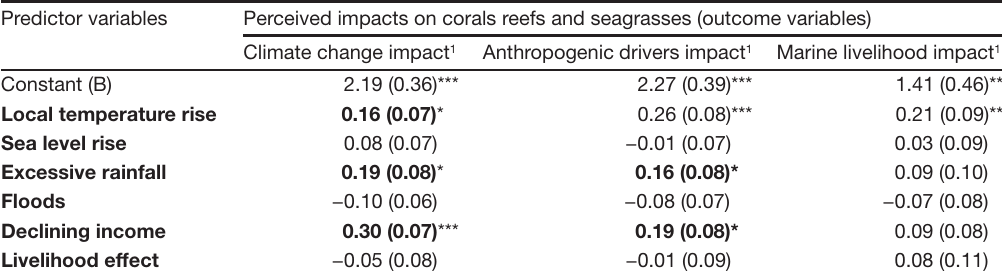
Table 4. Results of linear regression predicting the participants’ risk perception of climate change impact, anthropogenic pressures and marine livelihood from their personal experiences of climate-related events in the coastal marine environment of Palawan, Philippines (standard error in